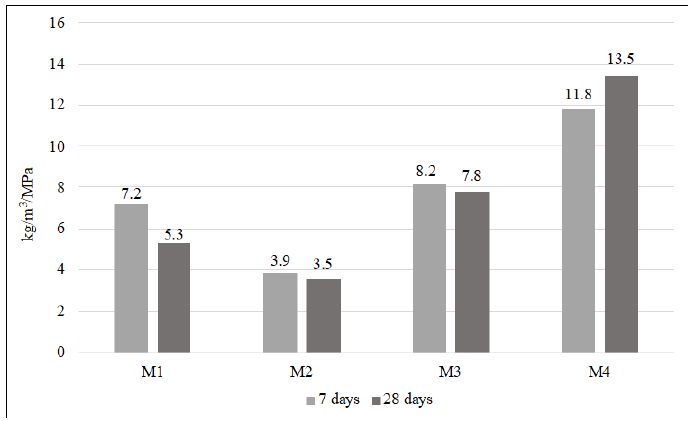
Figure 5. kg/m 3